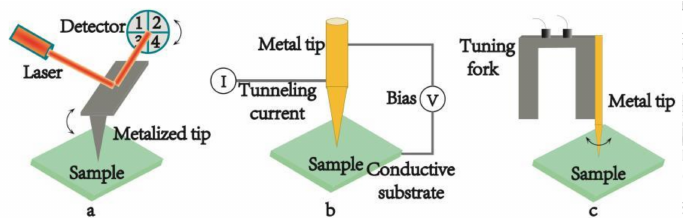
Figure 2. Schematic diagrams of the different scanning probe microscopy (SPM) feedback systems used in TERS. ( a ) atomic force microscopy (AFM) feedback system, ( b ) scanning tunneling microscopy (STM) feedback system, ( c ) shear force microscopy (SFM) feedback